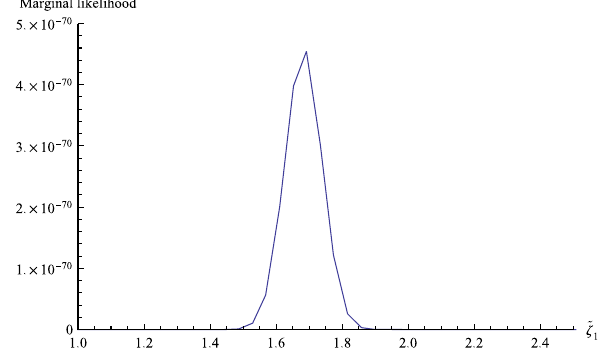
Fig. 4 Marginal likelihood of the parameter ˜ ζ 1 corresponding to the case 4, when ζ = ζ 1 ˙ a , a constant a